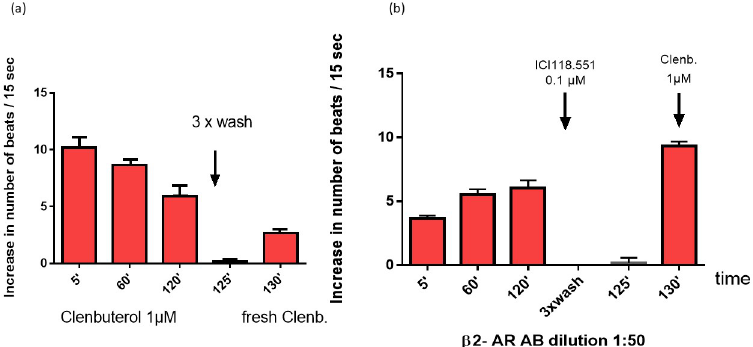
Fig 3. Desensitization of the β 2 adrenergic response by the β 2-adrenergic agonist clenbuterol (a). This receptor desensitization was missed if the cells were stimulated with the β 2-adrenergic AAb prepared from AD patients